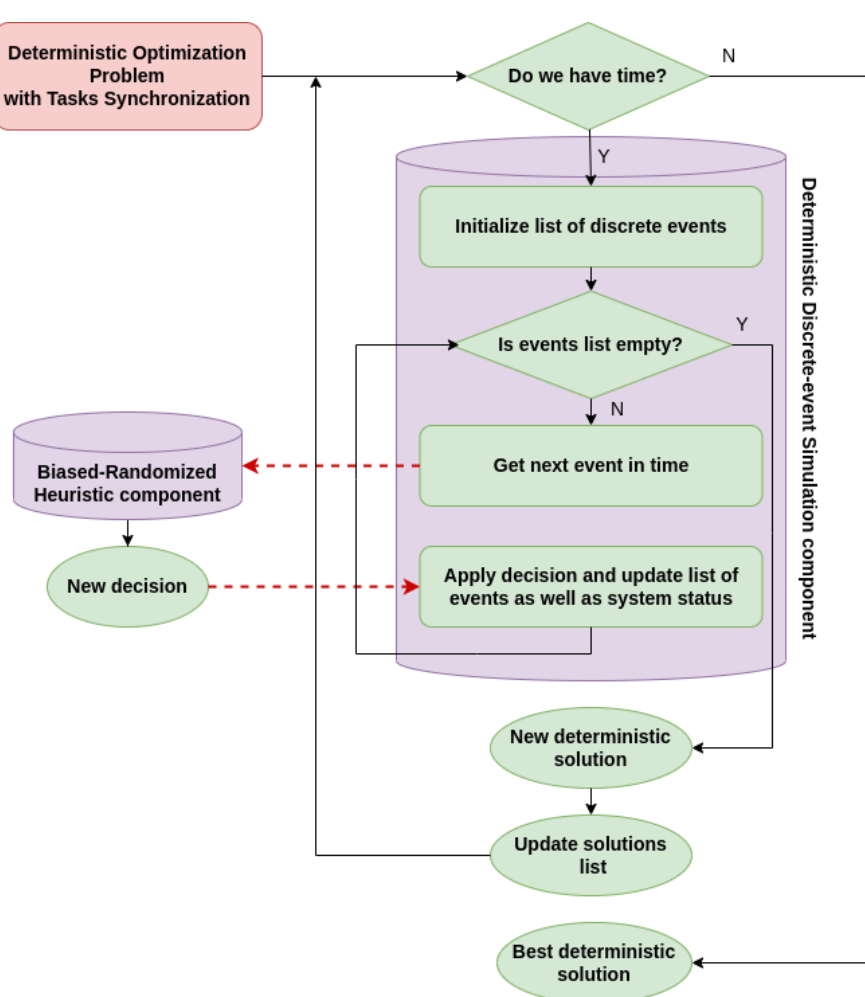
Figure 4. Flow-chart illustrating the DEH